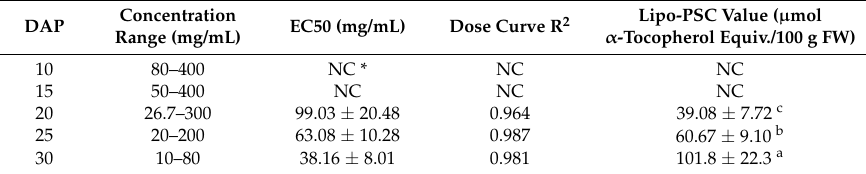
Table 2. Lipophilic antioxidant activity of sweet corn during days after